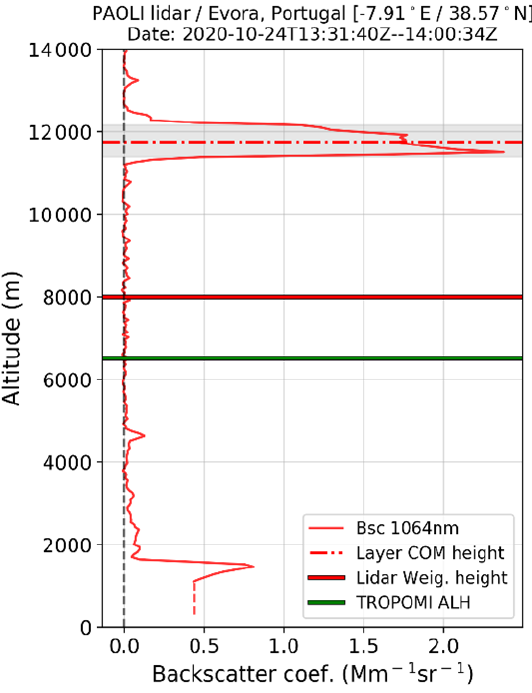
Figure 11. The same as Fig. 5 but for the PAOLI lidar